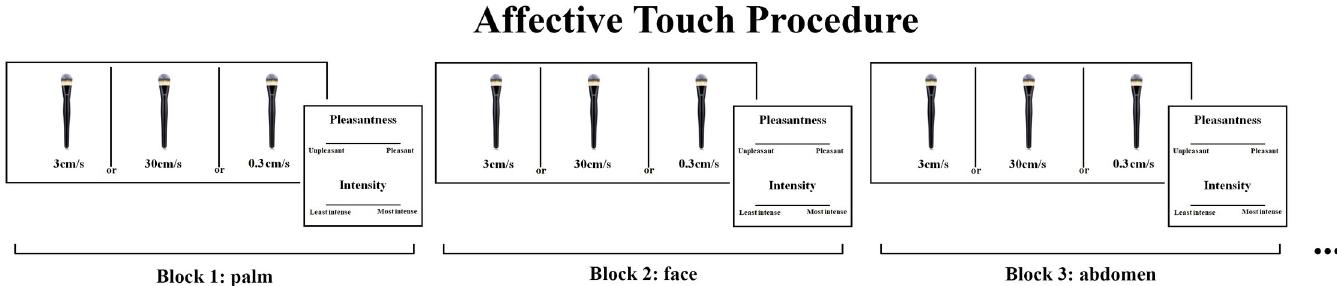
Fig 1. Schematic depiction of the study procedure. Participants were lying semi-horizontally in a comfortable, reclining chair whilst receiving manual brush strokes. In randomised blocks (each one corresponding to one body site), participants were asked to rate the pleasantness and intensity of the touch delivered by a female experimenter to the palm, face, abdomen, back and forearm at 3 cm/s (CT-optimal stroking) and 0.3 cm/s and 30 cm/s (non-CT optimal stroking) velocities.